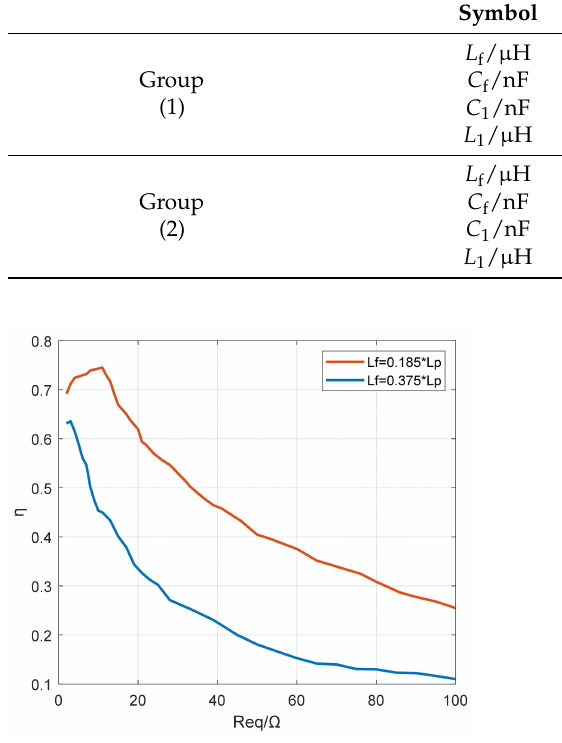
Figure 17. The efficiency curves of the two sets of experiments.